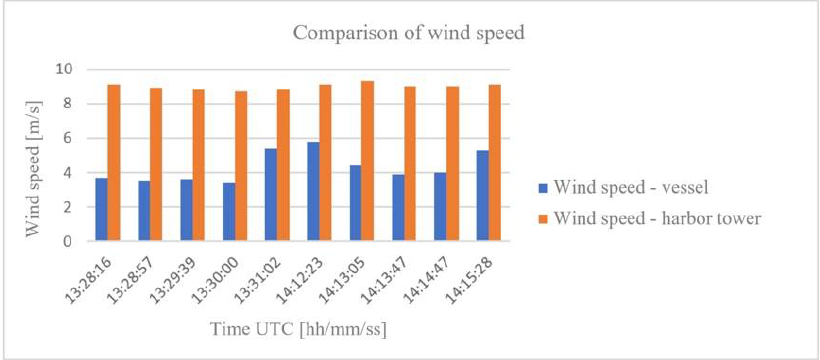
Figure 7. Comparison of wind speed from the vessel with the Harbor Master’s Office tower.